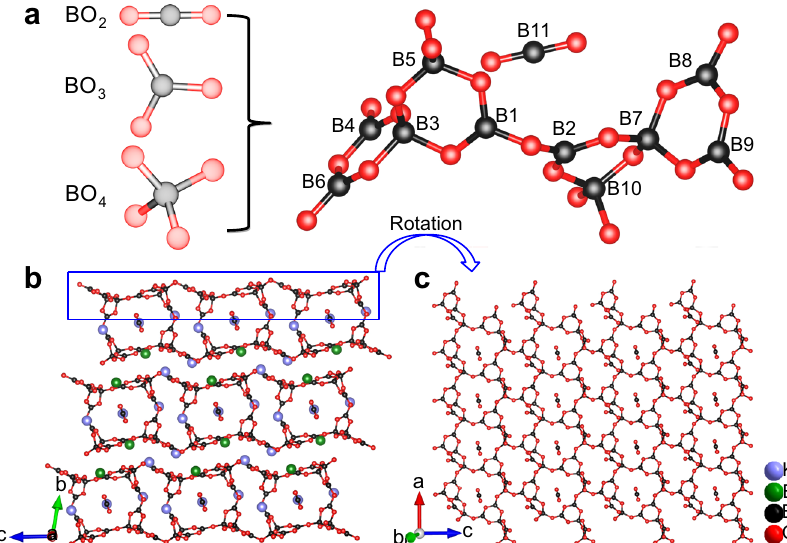
Fig. 1 Crystal-structural features of K 5 Ba 2 (B 10 O 17 ) 2 (BO 2 ). a B – O basic units and their relative positions in the asymmetric unit of K 5 Ba 2 (B 10 O 17 ) 2 (BO 2 ). K 5 Ba 2 [B 10 O 17 ] 2 (BO 2 ) presents the fi rst case that contains all the three available basic motifs simultaneously, namely BO 2 , BO 3 , and BO 4 units. b Crystal structure of K 5 Ba 2 (B 10 O 17 ) 2 (BO 2 ) viewed along the a -axis. c The 2 [B 5 O 9 ] ∞ in fi nite layer and isolated [BO 2 ] − anions in K 5 Ba 2 (B 10 O 17 ) 2 (BO 2 ). The adjacent fi nite layers further link to form 2 [B – AAAA – sequence. The atoms in 2 [B 5 O 9 ] ∞ in 10 O 17 ] ∞ double layers and then stack along the [010] direction in the lavender, green, black, and red are K, Ba, B, and O atoms, respectively. All the bonds of K – O and Ba – O are removed for clarity. The O atoms in isolated [BO 2 ] − units are non-bridging